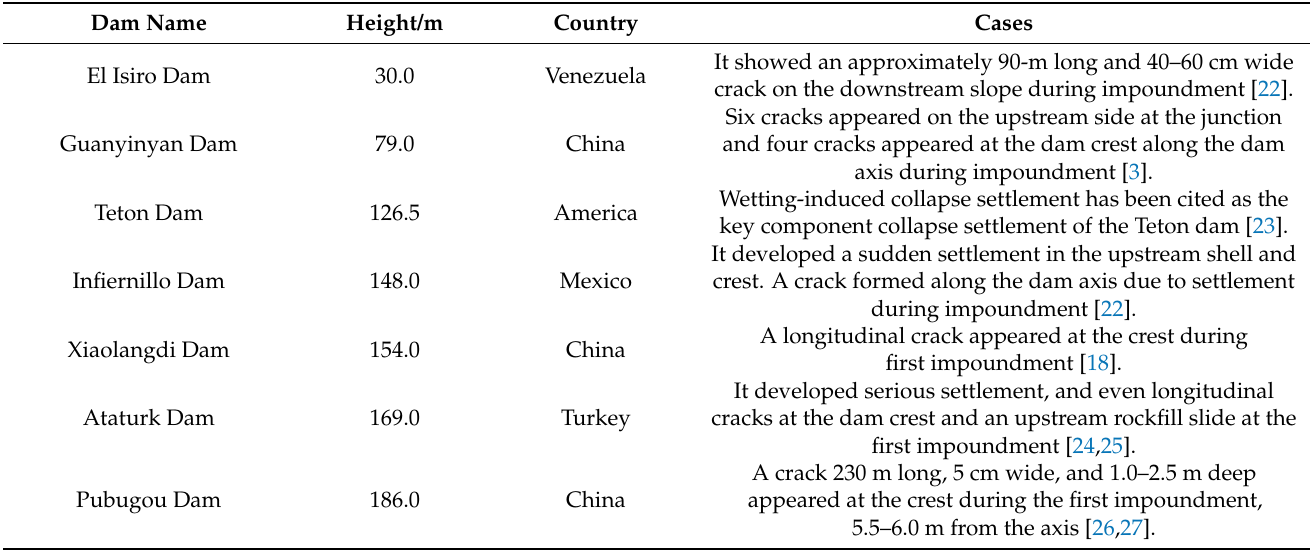
Table 1. The case of earth-rock dams showing cracks or even collapsing at first